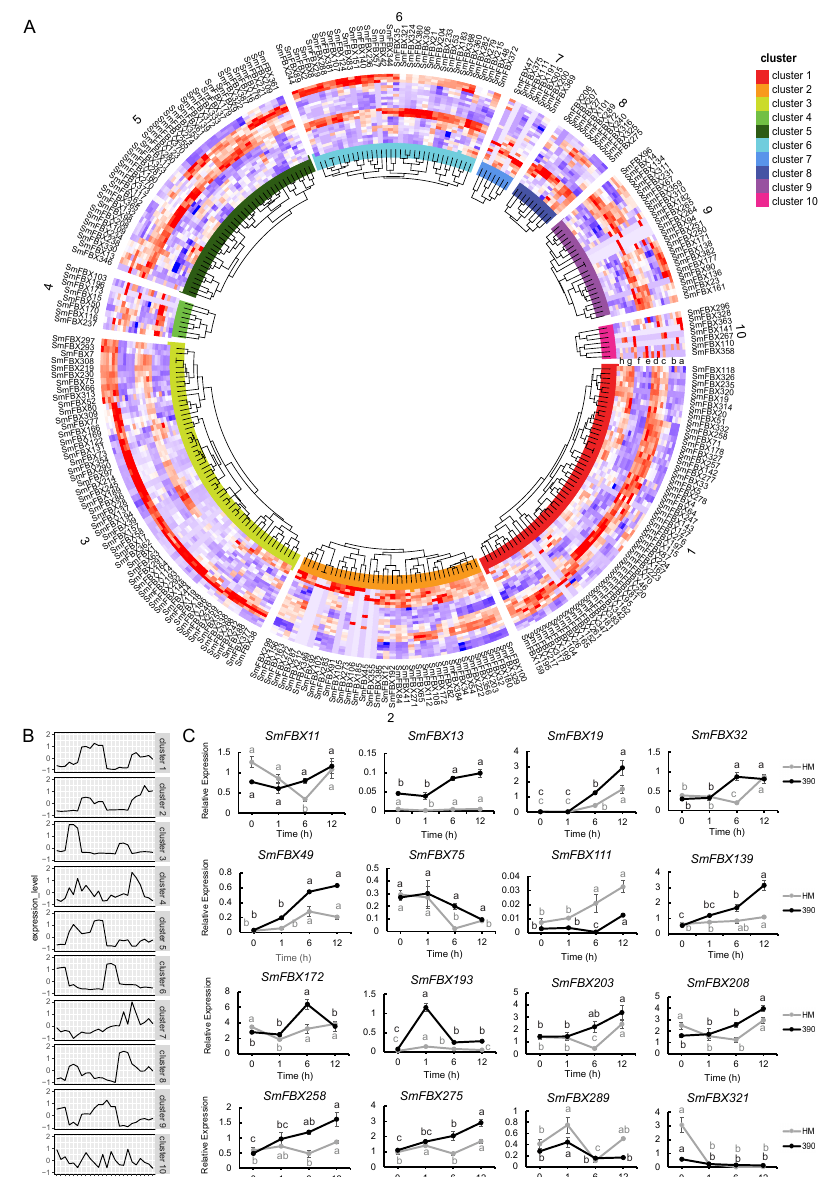
Figure 3. Transcriptome analysis and qRT-PCR verification results of the F-box candidate gene superfamily in eggplant heat-tolerant (390) and heat-sensitive (HM) varieties after high-temperature treatment. ( A ) F-box transcriptome heatmap analysis of eggplant heat-tolerant cultivar (390) and heat-sensitive cultivar (HM) after high-temperature treatment at 42 ◦ C. The different treatments are represented by the eight letters (a–h) in cluster 1, with a-d indicating high-temperature treatment in 390 0, (a), 1 (b), 6 (c), 12 h (d); and e–h indicating high-temperature treatment in HM, 0 (e), 1 (f), 6 (g), 12 h (h). Different clusters are marked with different colors, and the inner circle part indicates phylogenetic analysis of the the F-box genes. There were three biological replicates for each treatment. ( B ) The F-box candidate genes were divided into 10 clusters, and the expression model was obtained after counting the expression patterns of the F-box genes in each cluster. ( C ) qRT-PCR validation of the screened F-box candidate genes. Both 390 and HM varieties were subjected to high temperature (42 ◦ C) treatment, and samples were collected after 0, 1, 6, and 12 h. The calculation method was 2 − ∆∆ ct and the significant differences were analyzed using the least significant difference (LSD) for multiple comparisons, marked with letters. qRT-PCR, real-time quantitative reverse transcription